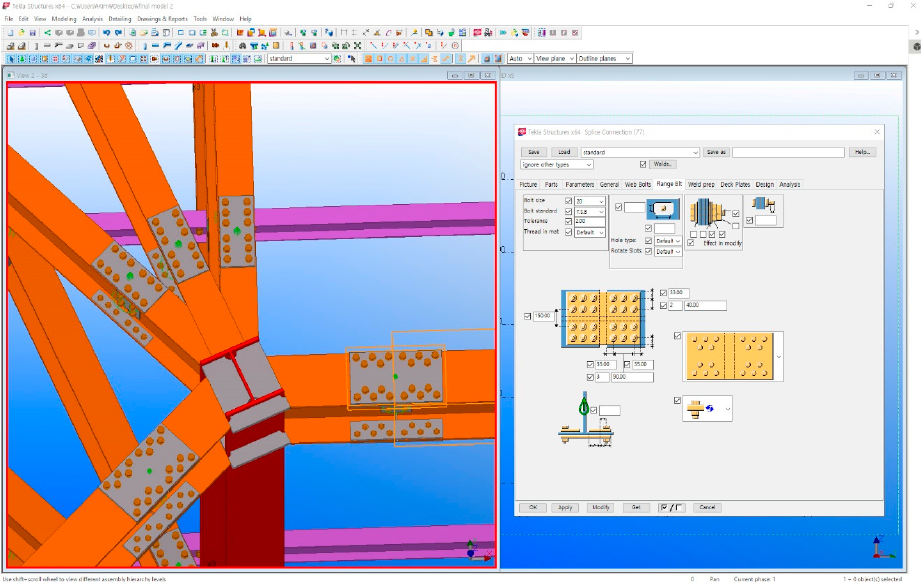
Figure 4. Detailed information regarding the joints of the steel frame members.